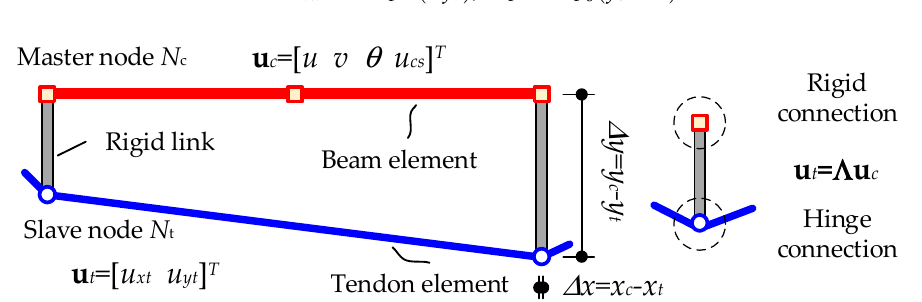
Figure 6. The rigid link connection between the beam and tendon elements.